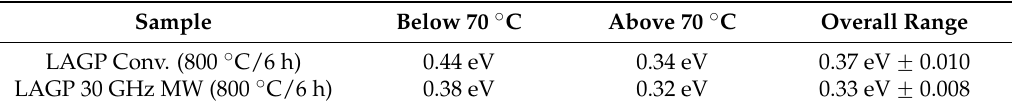
Table 5. Activation energies of optimized conventionally and MW heated-treated LAGP samples below and higher than 70 ˝